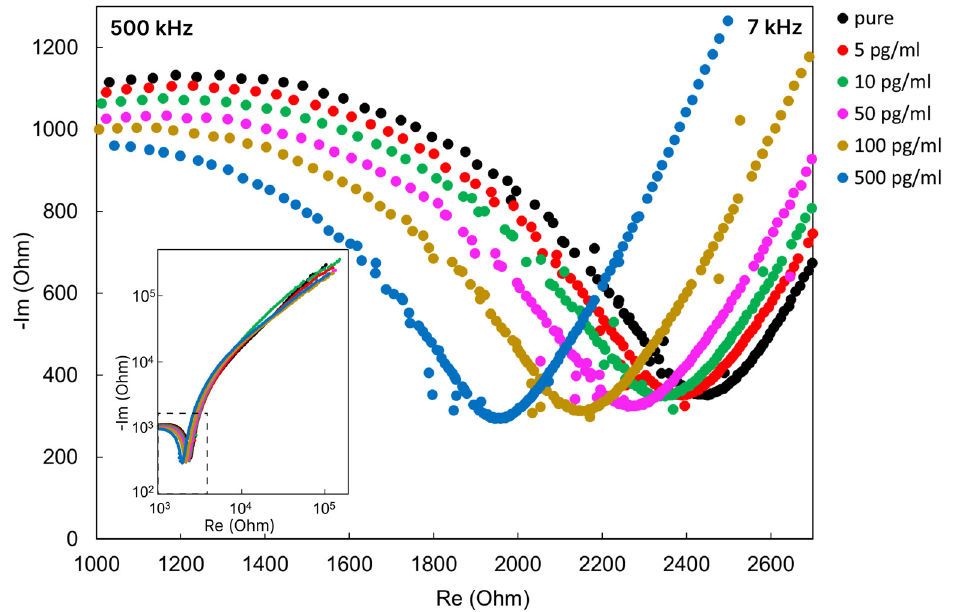
Figure 11. Nyquist plot for the biochip after immersion in omalizumab solutions of various concen- trations.